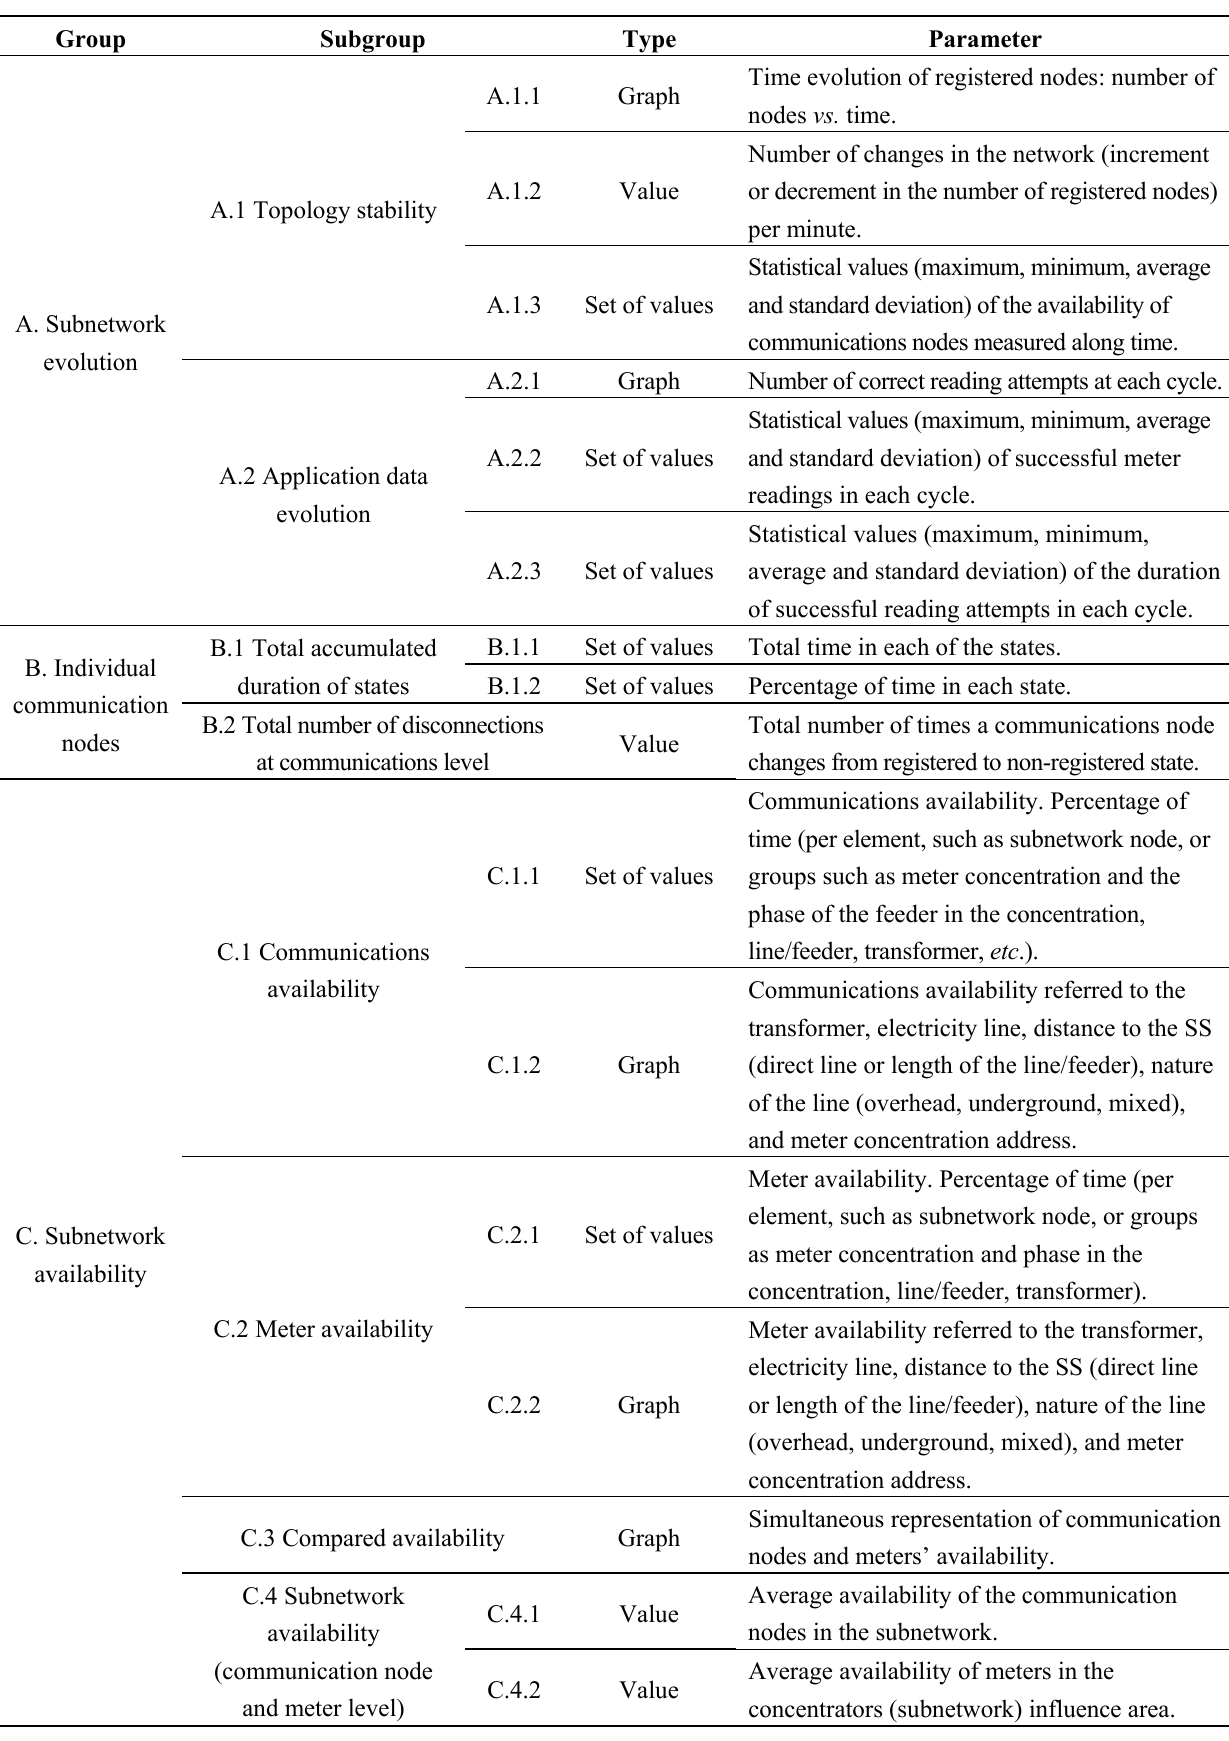
Table 2. Detailed parameters proposed for PLC-based Smart Metering assessment.